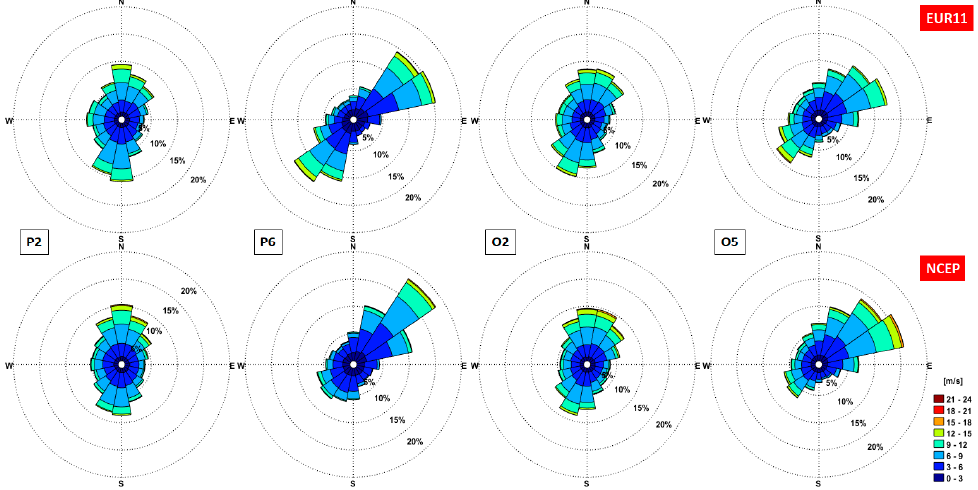
Figure 7. Directional distribution, U10 classes in various nearshore (P2, P6) and offshore (O2, O5) sites, wind speeds from EUR11 (top panels), and NCEP (bottom panels), time interval 1987–2009.